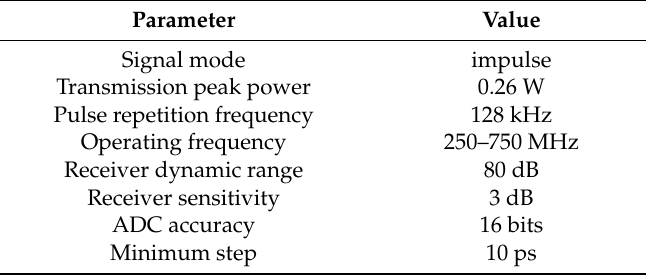
Table 1. Key parameters of the multistatic UWB radar.